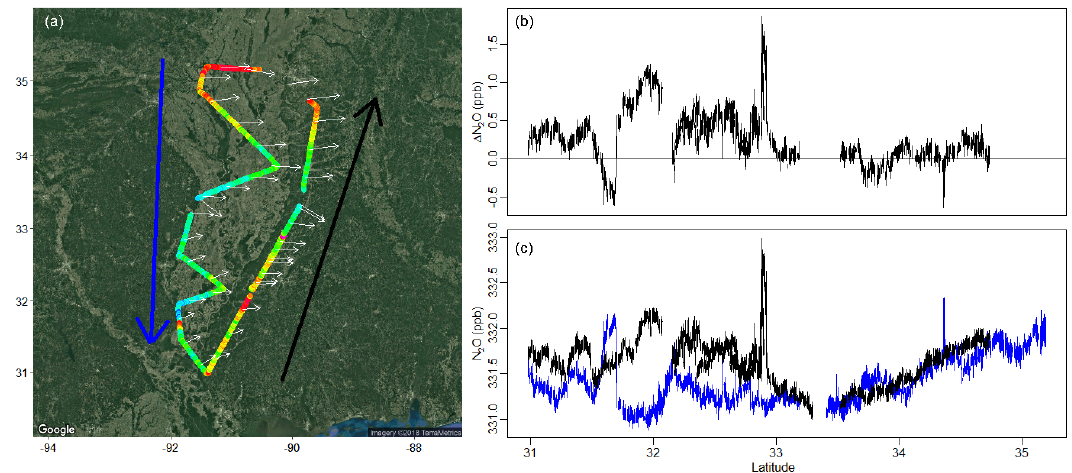
Figure 13. (a) Flight path with N 2 O signal and wind direction (white arrows). Blue and black arrows show the direction of the plane’s route and indicate upwind and downwind transects. (c) N 2 O signal as a function of latitude with upwind and downwind transects colored by blue and black, respectively. (b) Difference in N 2 O between downwind and upwind transects as a function of